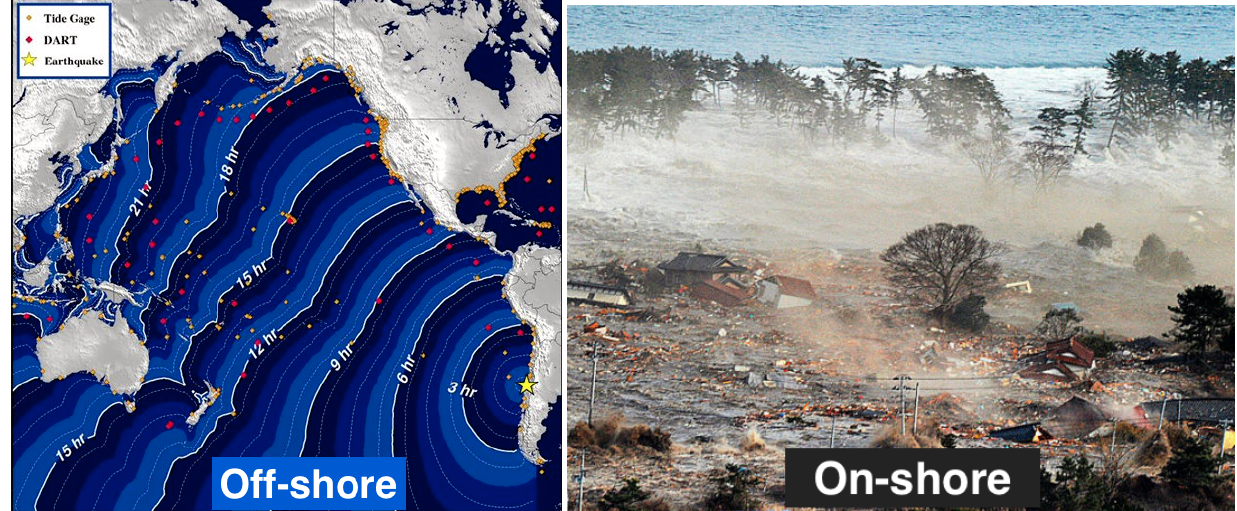
Figure 3. The off-shore tsunami is, effectively, a two-dimensional long-wave ( left , Chilean tsunami, 2010). On-shore, however, it becomes turbulent and multi-phase—water, sand, dirt, and debris ( right , Tohoku tsunami, Japan, 2011). Left : adapted from NOAA Tsunami Warning System. Right : image credit: Reuter/Kyodo found at www.theatlantic.com/ photo/2011/03/earthquake-in-japan/100022/.